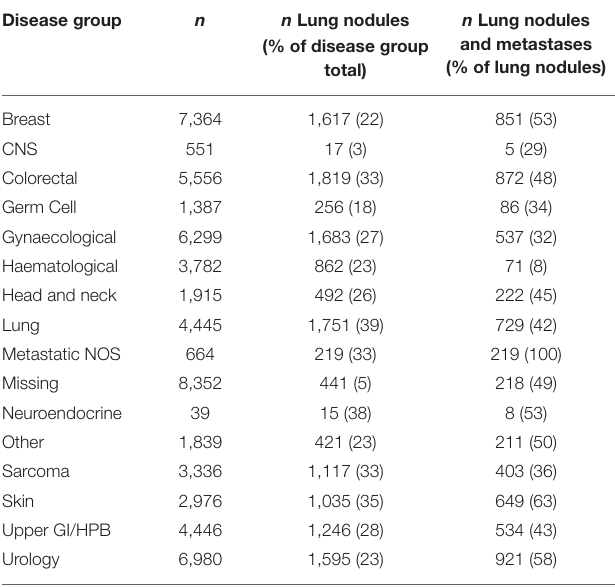
TABLE 1 | Summary of lung nodule and metastatic status amongst primary cancer groups. Disease